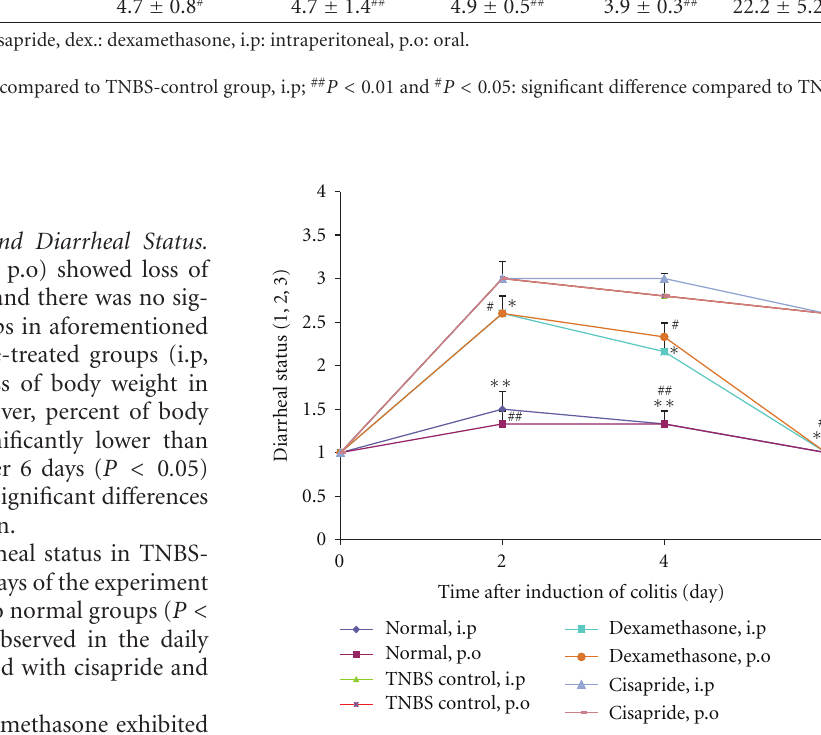
Figure 1: Changes in diarrheal status before (day 0) and during 6 days of treatment after induction of colitis (TNBS, 50 mg/kg) in rats. Values are means ± SEM ( n = 6). ∗∗ P < 0 . 01 and ∗ P < 0 . 05 compared with TNBS-control group, i.p; ## P < 0 . 01 and # P < 0 . 05 compared with TNBS-control group, p.o TNBS, 2, 4, 6- trinitrobenzenesulfonic acid. Stool consistency was daily checked in rats (1) formed stools, (2) loosed stools, and (3)